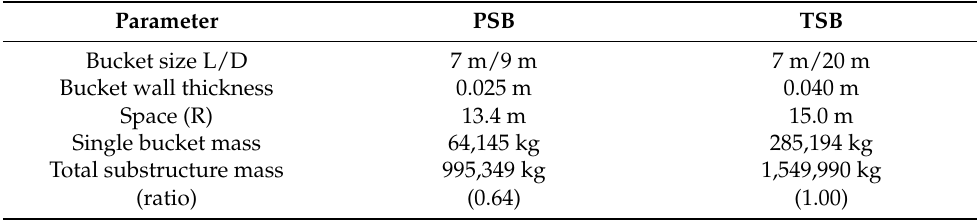
Figure 10. Illustration of analysis models. Table 5. Substructure